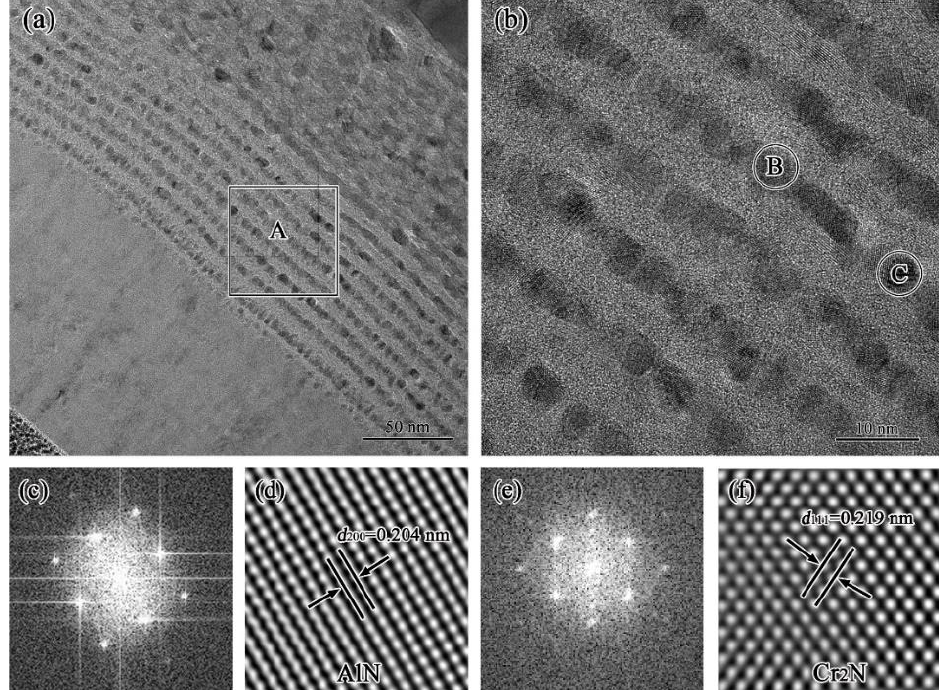
Figure 4. ( a ) HAADF-STEM image of the annealed sample in which the rectangular box denotes the location of the HR-TEM analysis shown in ( b ), ( c , e ) are the FFT (fast Fourier transform) images of the areas B and C as denoted in ( b ), respectively, and ( d , f ) are the IFFT (inverse fast Fourier transform) images of the areas B and C as denoted in ( b ), respectively.